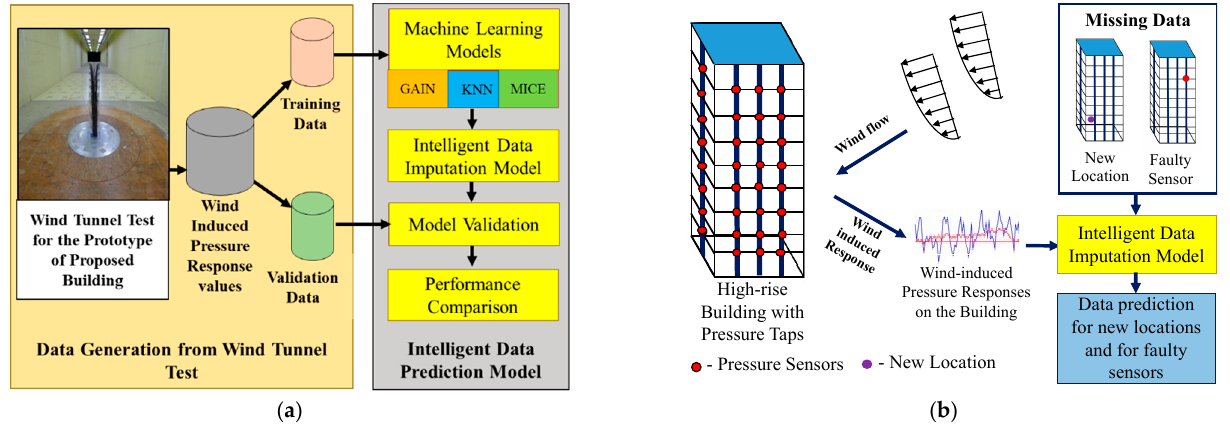
Figure 4. IDPM model. ( a ) Workflow of machine-learning-based intelligent data prediction model for wind pressures; ( b ) workflow of intelligent data prediction model to predict the missing values.